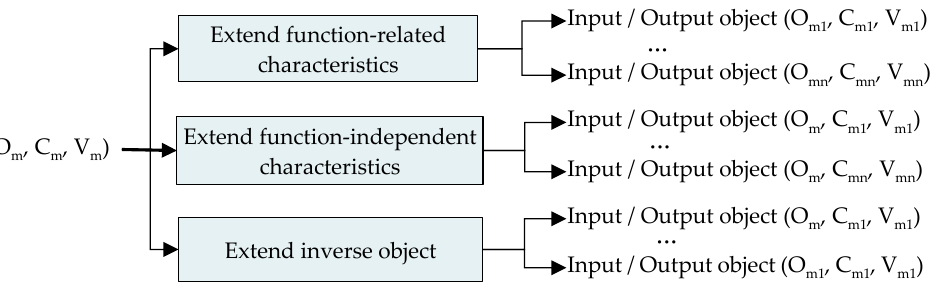
Figure 5. Model for extending the action object based on the divergence tree.